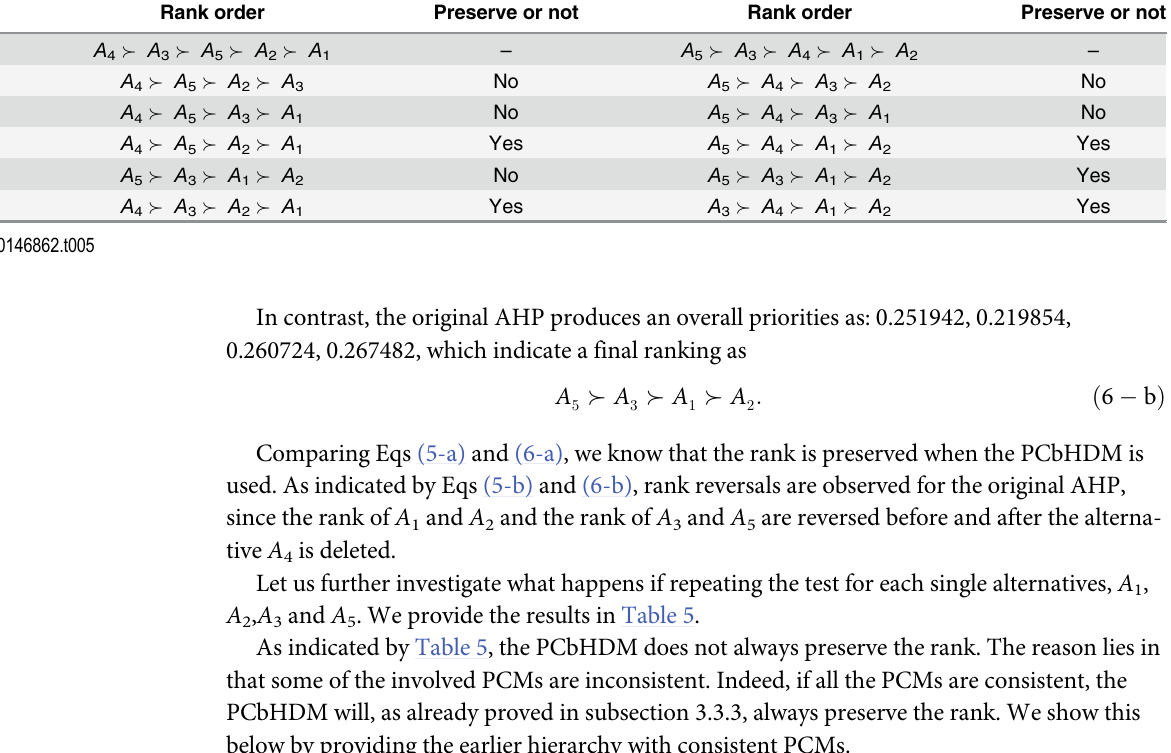
Table 5. Rank order for each single deletion.